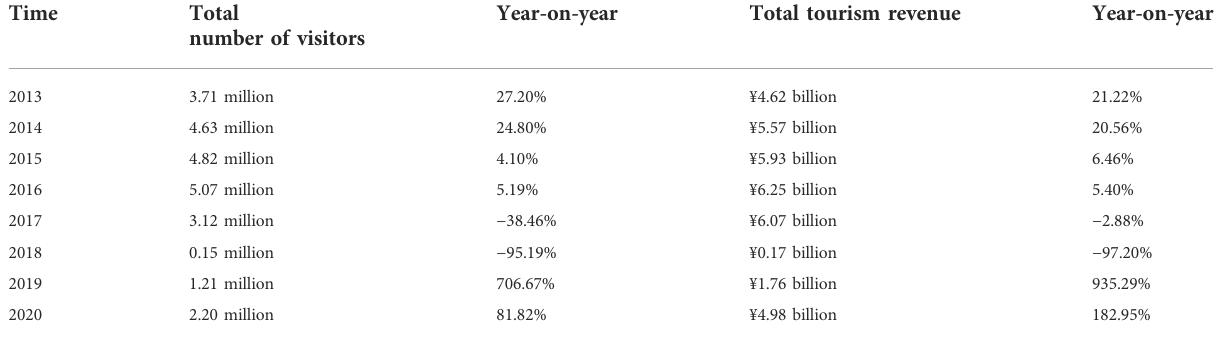
TABLE 1 Tourism economic statistics of Jiuzhaigou Scenic Area from 2013 to 2020. Time Total number of